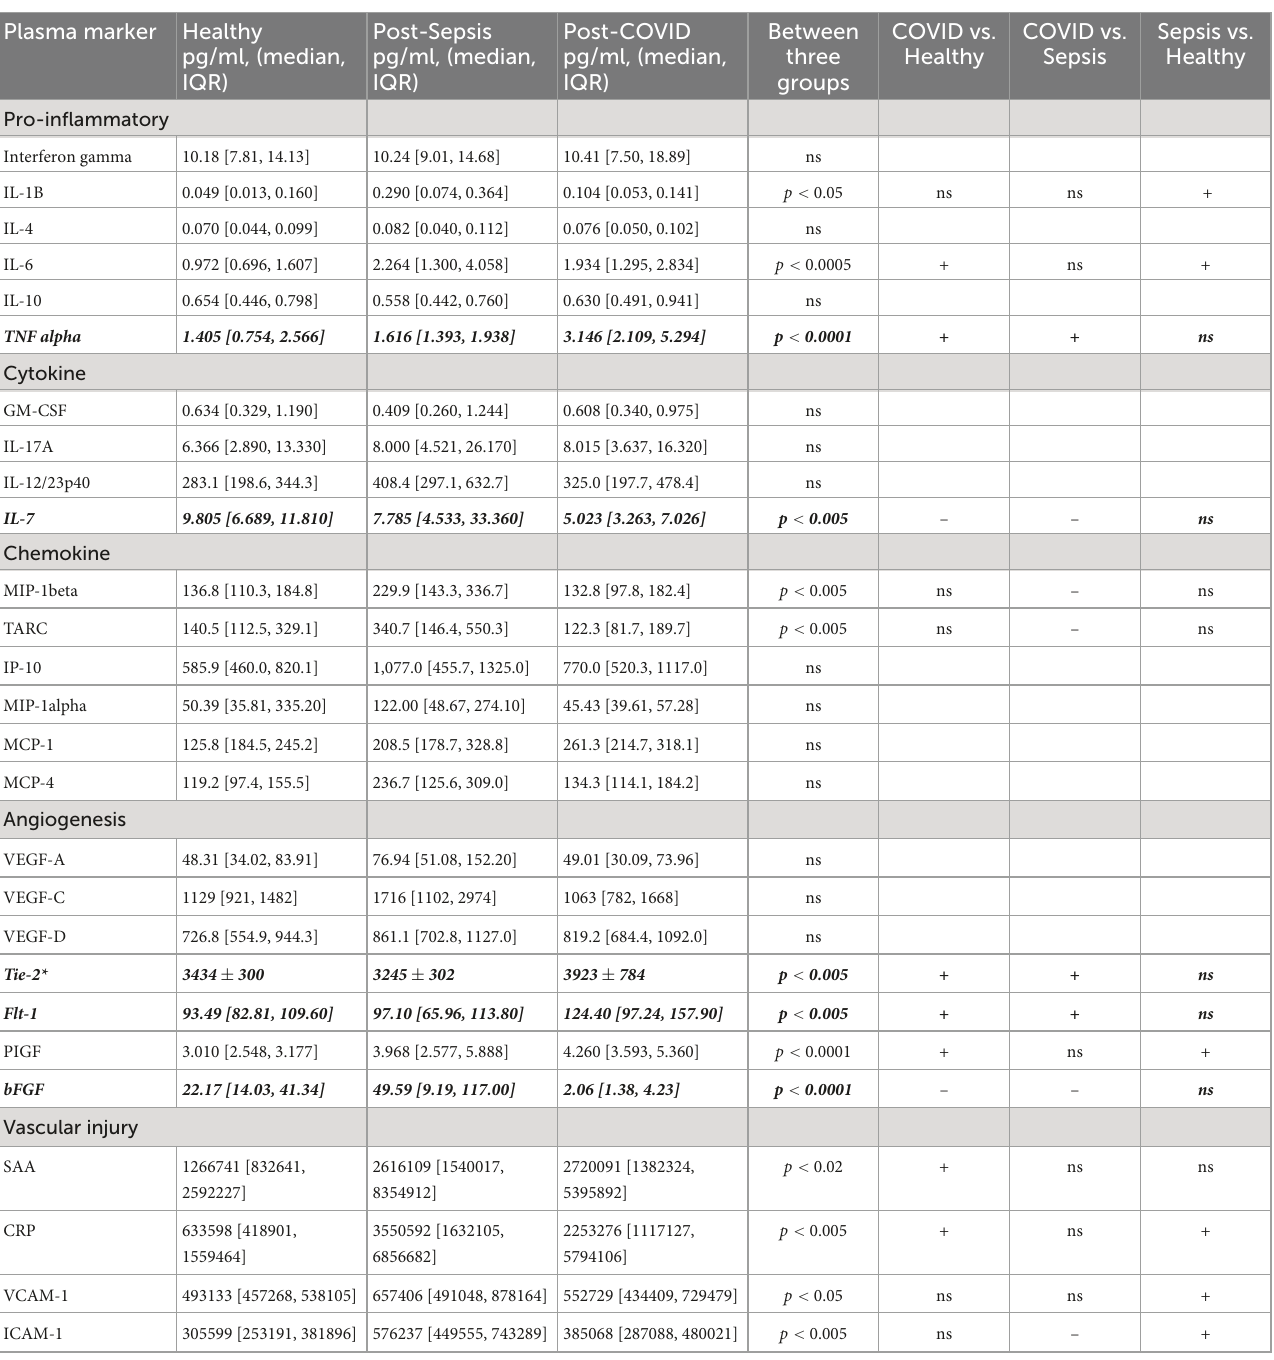
TABLE 1 Multiplex assay results.